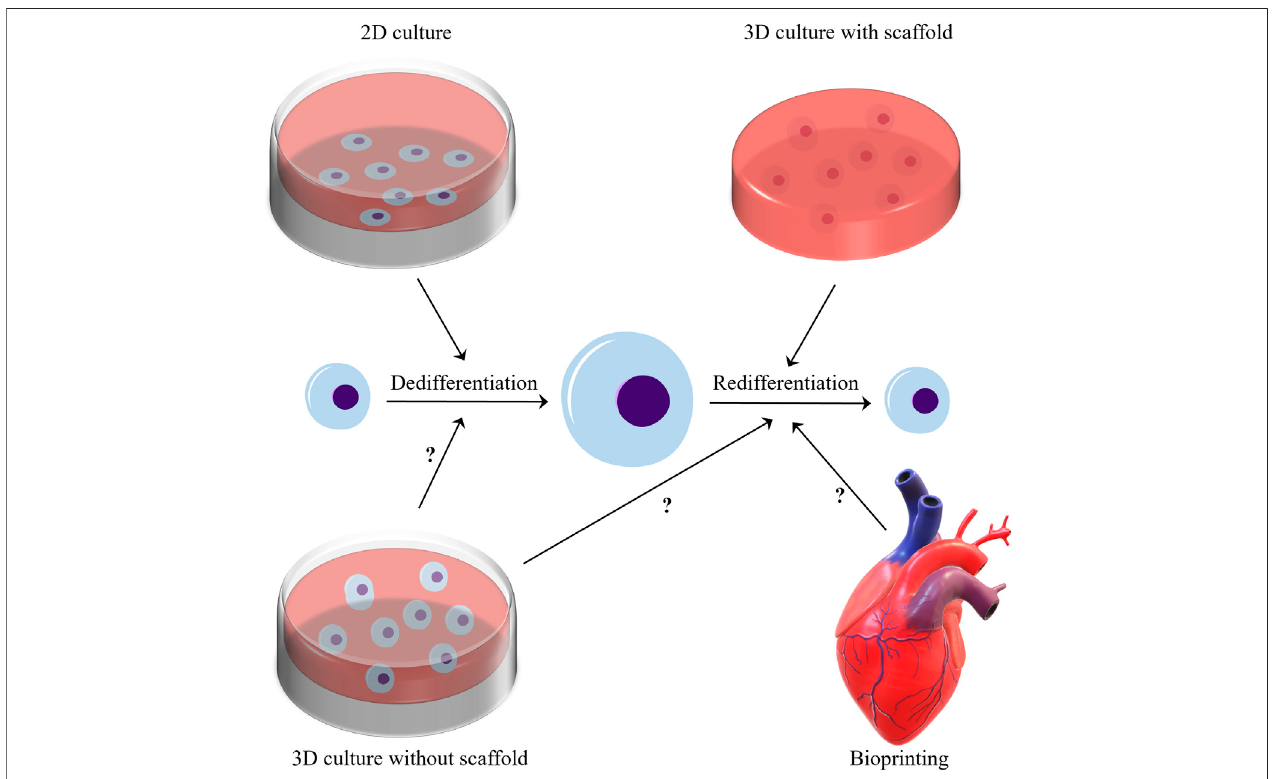
FIGURE 1 | In the microenvironment of two-dimensional culture, chondrocytes generally undergo dedifferentiation after proliferation. Three-dimensional culture withscaffolds has agoodability tomodulate the redifferentiation ofchondrocytes.And doesthe three-positionculture withoutscaffoldand bioprintinghave the abilityto modulate the redifferentiation of chondrocytes? This issue needs further research to